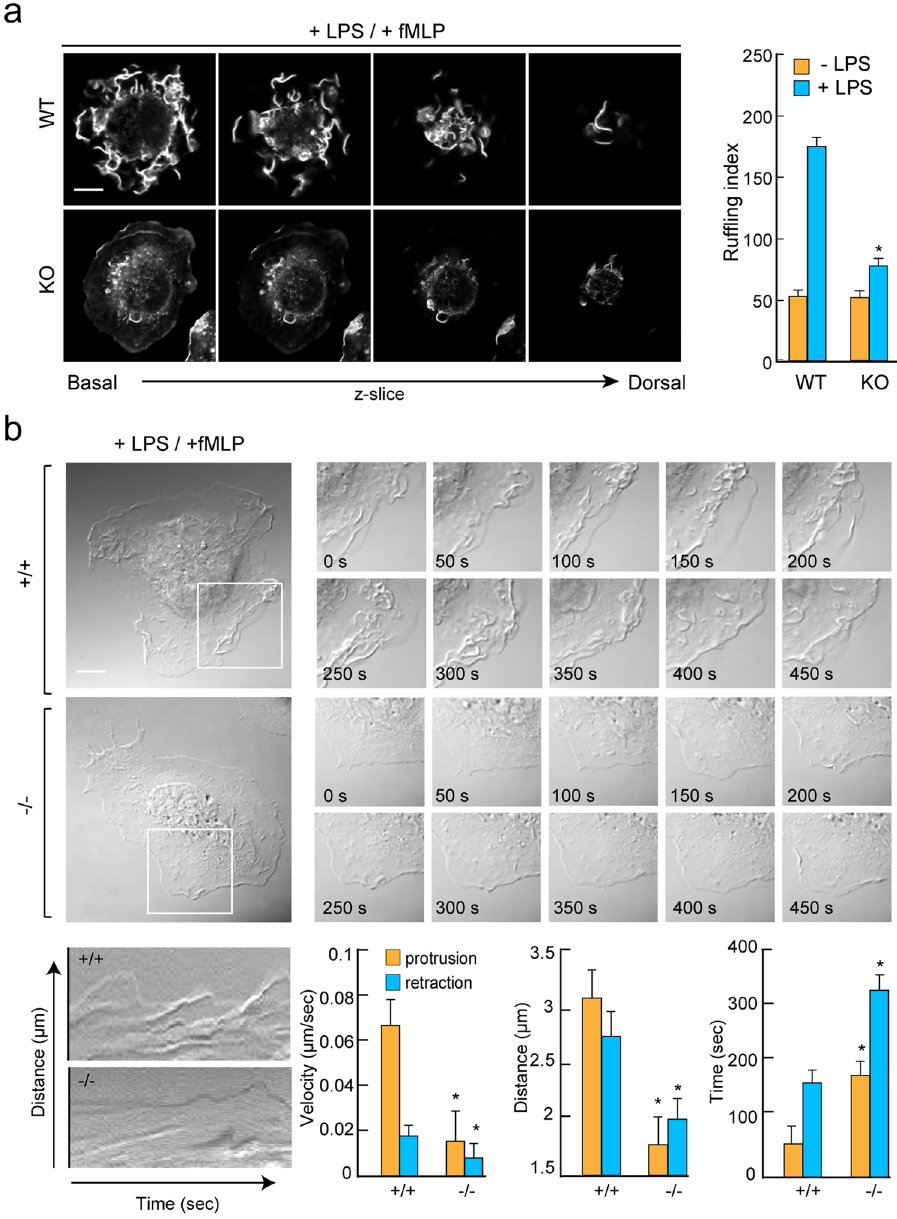
Figure 4. TAGLN2 mediates membrane ruffling in LPS-stimulated macrophages. ( a ) Membrane ruffling formation in fMLP (200 nM)-stimulated peritoneal macrophages from wild-type and TAGLN2 − / − mice. LPS- stimulated and serum-starved peritoneal macrophages were treated with fMLP for 2 min, fixed, and stained for F-actin with TRITC phalloidin. Scale bars, 5 μ m. Quantification of fMLP-induced membrane ruffles in wild-type and TAGLN2 − / − macrophages by ruffling index. Data are expressed as means ± SEM of the ruffling index of four random fields. * P < 0.05 vs LPS-treated wild-type macrophages. This result is a representative of three independent experiments. ( b ) Lack of membrane protrusive activity in TAGLN2 − / − macrophages. Representative frames from time-lapse videos and kymographs obtained after fMLP stimulation. Peritoneal macrophages from wild-type and TAGLN2 − / − mice were serum-starved for 3 h before fMLP stimulation. DIC images were collected at 10-second intervals for 10 min (see Supplementary Videos S6–S7). Multiple kymographs ( n = 4–6) were generated from each cell using the EMBL ImageJ software. Quantitative analysis of protrusion activity (velocity, distance, and time) included a total of three different regions per treatment from each experiment ( n = 3 independent experiments). Scale bars, 5 μ m. ( c ) SEM images of ruffling in wild-type and TAGLN2 − / − macrophages. Scale bars, 5 μ